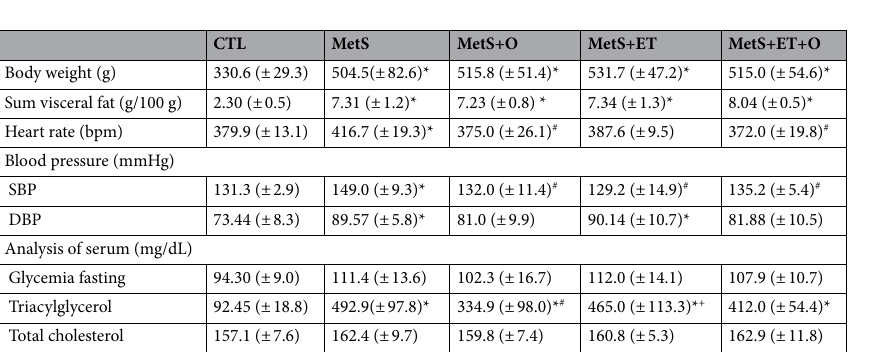
Table 1. MetS parameters and Heart Rate. CTL–Control, MetS–Metabolic Syndrome, MetS+O–Metabolic Syndrome and Okra, MetS+ET–Metabolic Syndrome and Exercise Training, MeTS+ET+O–Metabolic Syndrome and Exercise Training and Okra. SBP–Systolic Blood Pressure, DBP–Diastolic Blood Pressure. *Different from CTL, # Different from MetS, + Different from MetS+O. p ≤